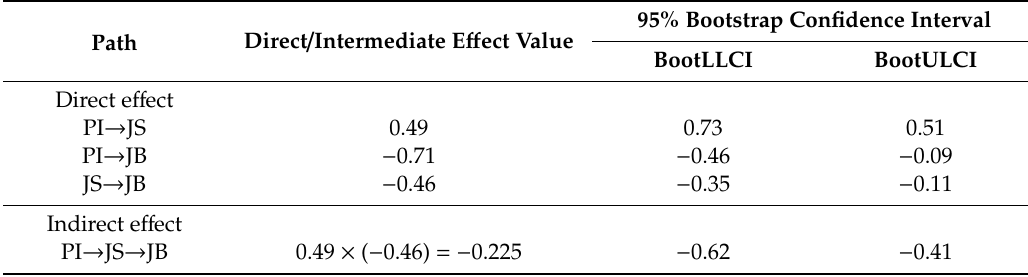
Table 3. Bootstrap analysis of mediating e ff ect significance